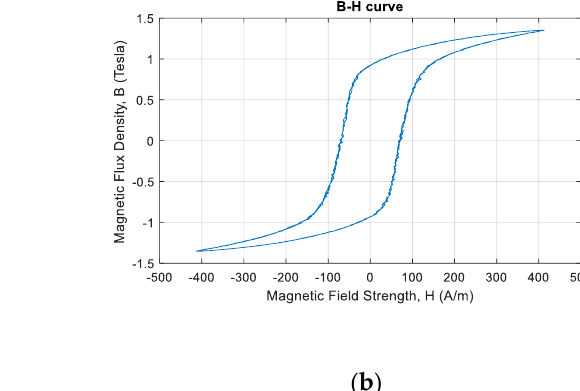
Figure 11. Integration waveform and B – H curve after correcting initial integration position and re- moving the DC components. ( a ) Normal voltage integration waveform. ( b ) Normal B – H curve. 4.5. Effects of Harmonics on Measurements The digital method of magnetic characterization tool utilized a pure sinusoidal wave- form as a test source, but it might not be capable of testing a power transformer [3]. A practical solution is using a voltage source from the electric grid. However, the frequency and harmonic will cause error measurements. As mentioned earlier, the wave crest of a purely sinusoidal voltage waveform should be located at 90° in phase. However, in real-life scenarios, the power supply often has harmonic content. Thus, the crest is not usually at 90°, which can result in integration